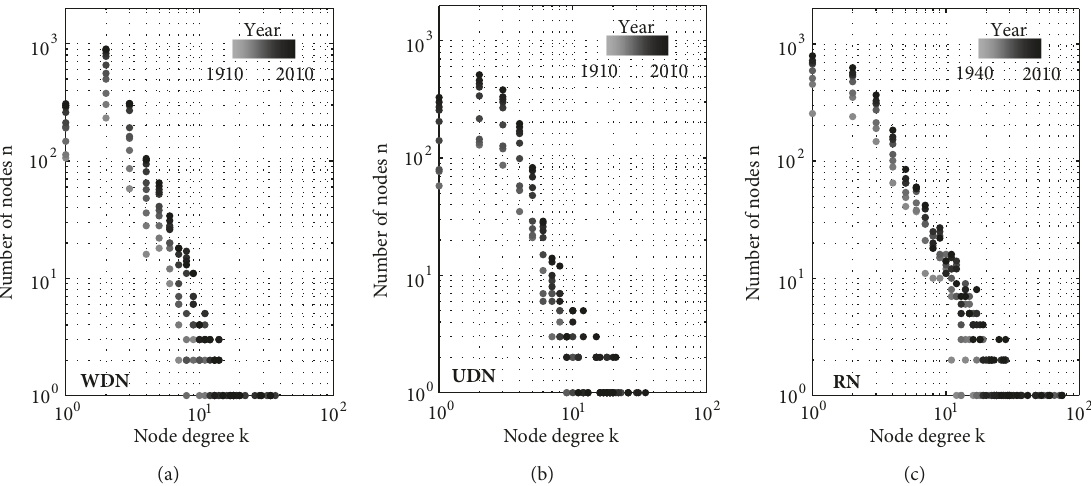
Figure 5: Heavy tailed dual degree distribution overtime of (a) the WDN, (b) the UDN, and (c) the RN. The color shading from light grey to black indicates the evolution of the network. Detailed results of the statistical curve fitting can be found in Appendix